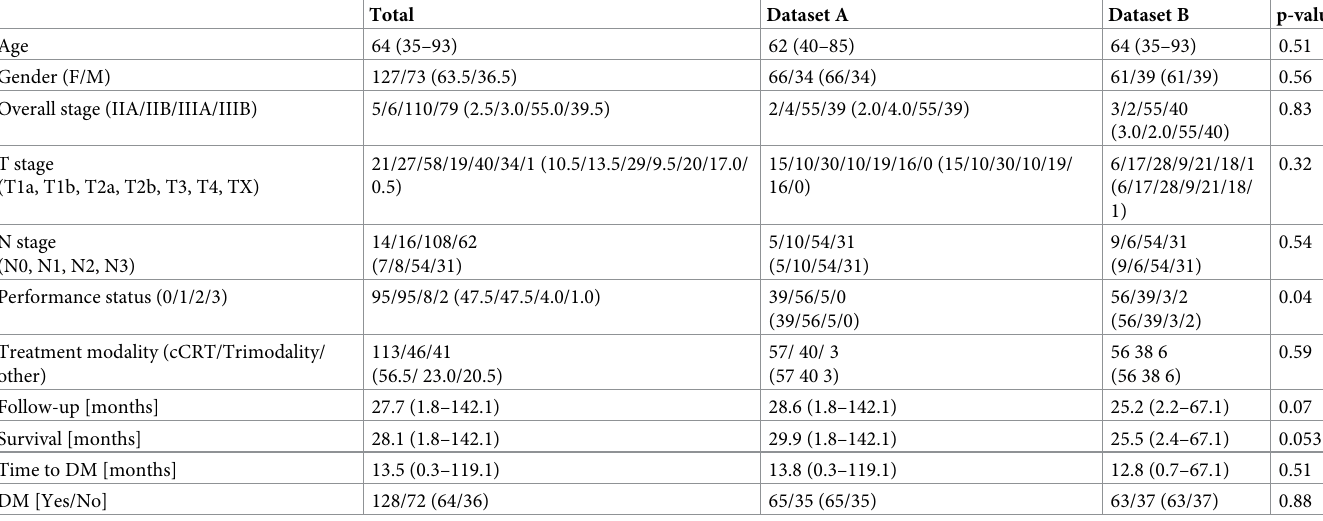
Table 1. Patient characteristics, treatment information, and